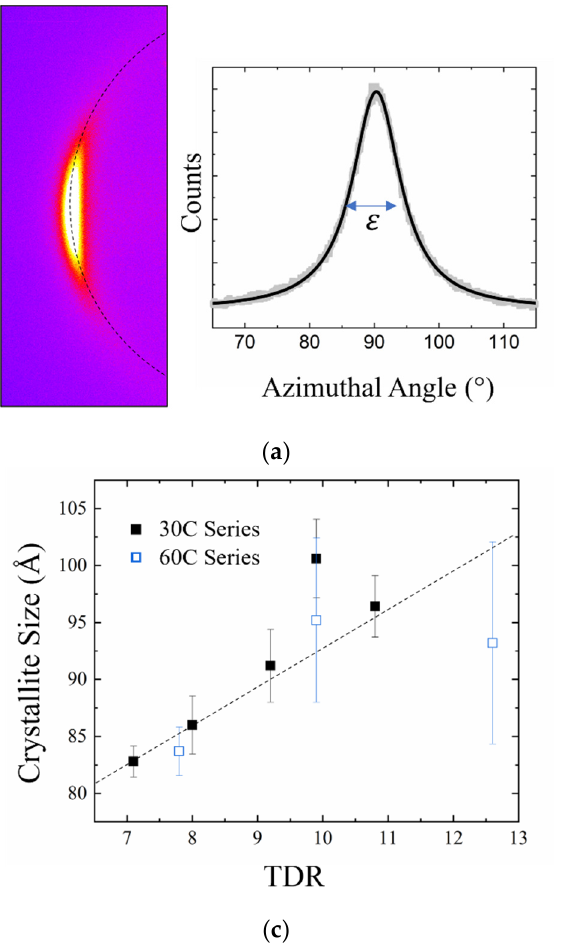
Figure 6. ( a ) A typical 2D diffraction pattern from a WF ( left ) and the peak profile resulting from azimuthally integrating along the ring indicated by the dashed line ( right ). Relationship between TDR and ( b ) orientation, ( c ) crystallite size, and ( d ) crystallinity for the WFs measured in this study. The error bars represent ( a , b ) the standard deviation and ( c , d ) the experimental uncertainty.